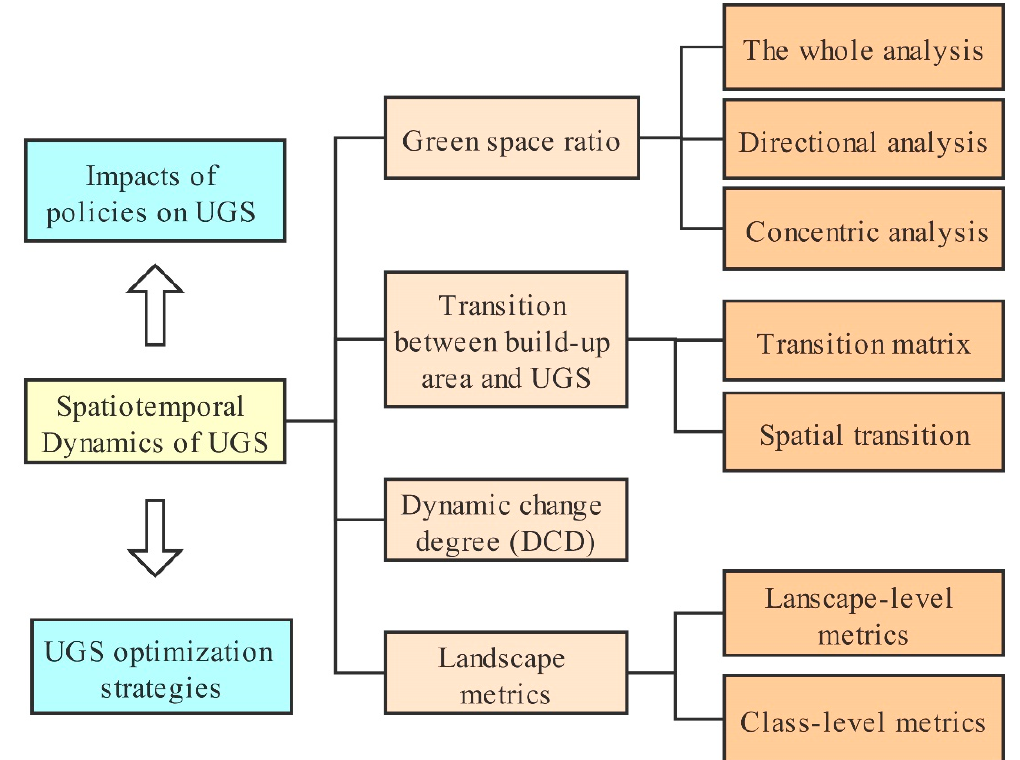
Figure 3. Methodological flow chart. UGS: urban green space; DCD: dynamic change degree.